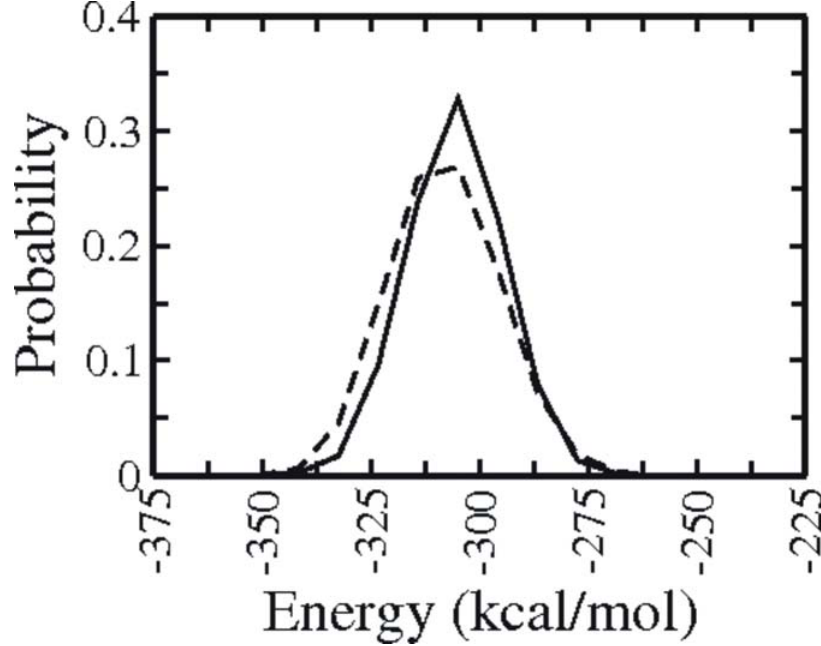
Figure 6. Distribution of the total potential energy of all sampled conformations from the BP-Rex MD simulation (continuous line) and T-Rex MD simulation (dashed